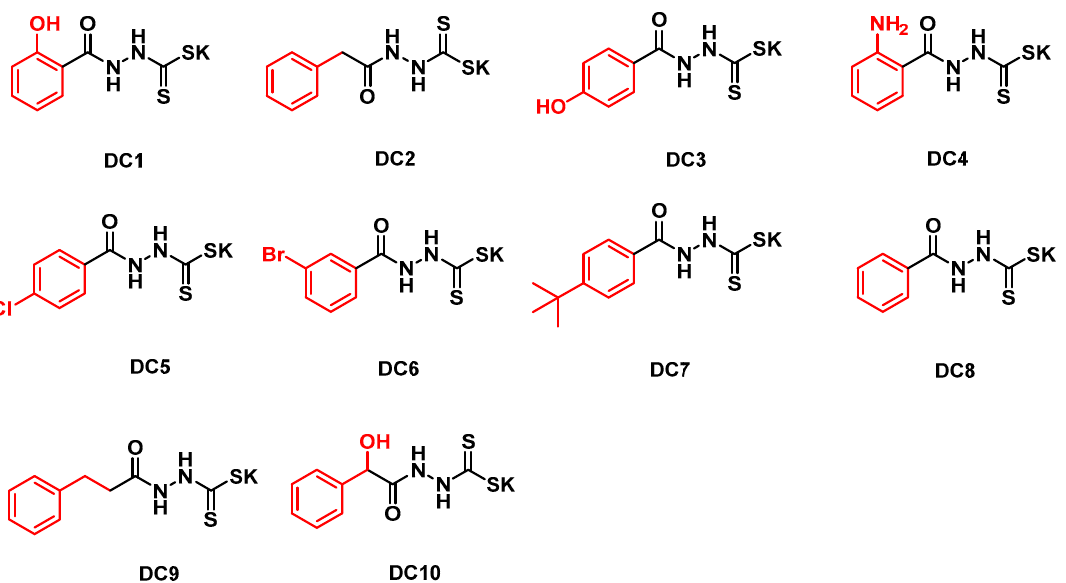
Figure 1. Structures of the synthesized dithiocarbamate derivatives.